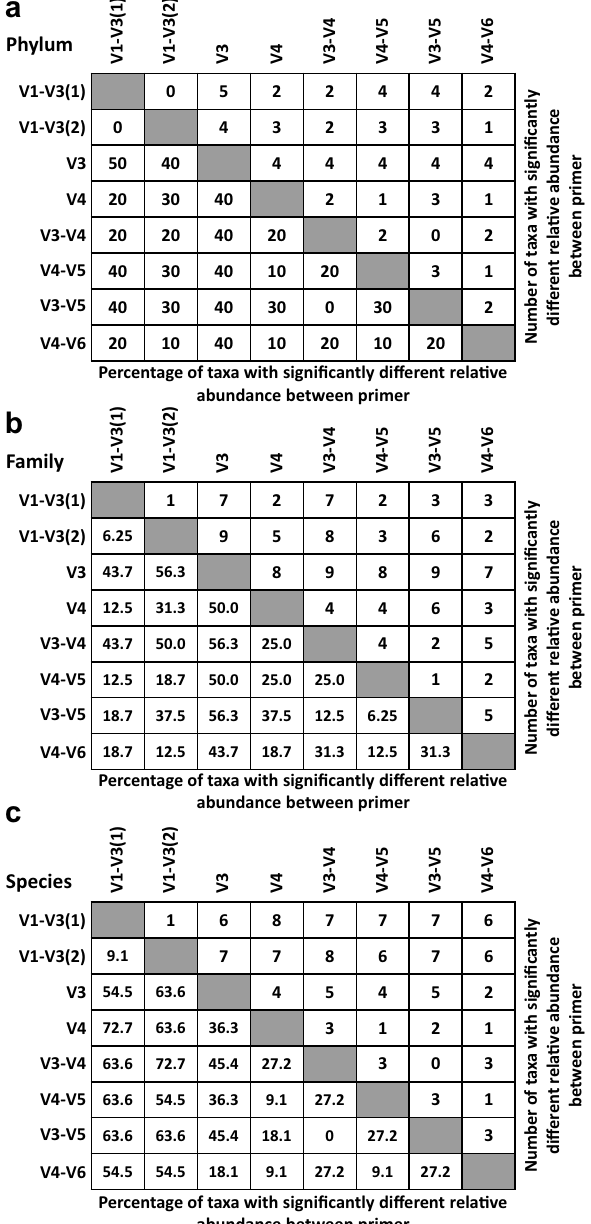
Figure 2. Number and percentage of taxa significantly different in relative abundance level between primer pairs. (a) phylum level, (b) family level and (c) species level. Number of taxa that were characterized by significant differences in relative abundance were counted between primer pairs. The percentage of the taxa were calculated for each primer pair comparison: (number of taxa that were significantly ( P < 0.05) different in relative abundance level/total number of taxa for each taxonomical level) ×